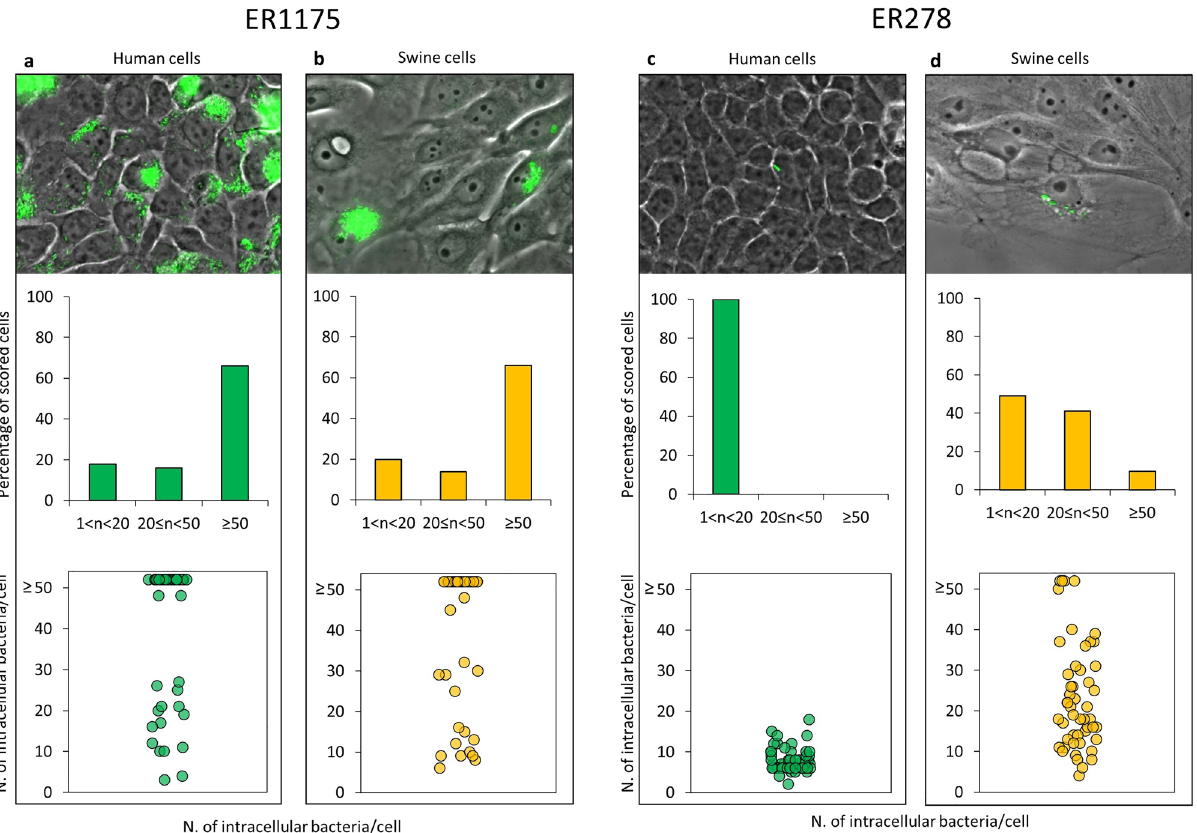
Figure 6. Intracellular replication phenotype of ER1175 and ER278 strains in human and swine cells. Each panel ( a – d ) contains: a representative image of intracellular replication of S . Derby representative strains ER1175 and ER278; a graph displaying the percentage of infected cells carrying 1–20, 20–50 and ≥ 50 Salmonellae 24 h post infection; a graph reporting the number of internalized bacteria per cell (each dot represents one infected cell). ≥ 50 infected cells were scored for each